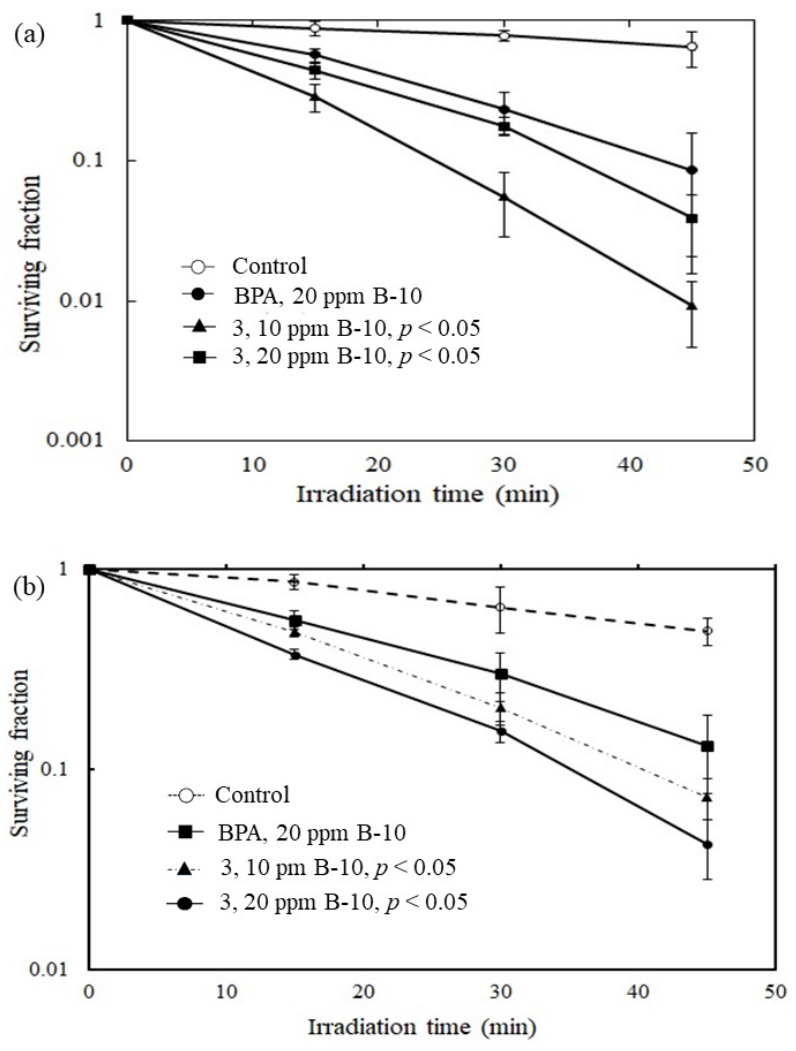
Figure 3. Plots of surviving fraction vs. irradiation time. ( a ) The C6 gliosarcoma cells. It shows the preliminary in vitro killing e ff ects of 3 where it has been observed that 3 demonstrated significantly improved killing e ff ects for C6 gliosarcoma tumor cells when compared to that with the clinical drug BPA under the same operating conditions. ( b ) The rat fibroblast-like synoviocytes (FLS) cells, compound 3 shows similar improved killing e ff ects when compared to that with BPA. p < 0.05 relative to control.